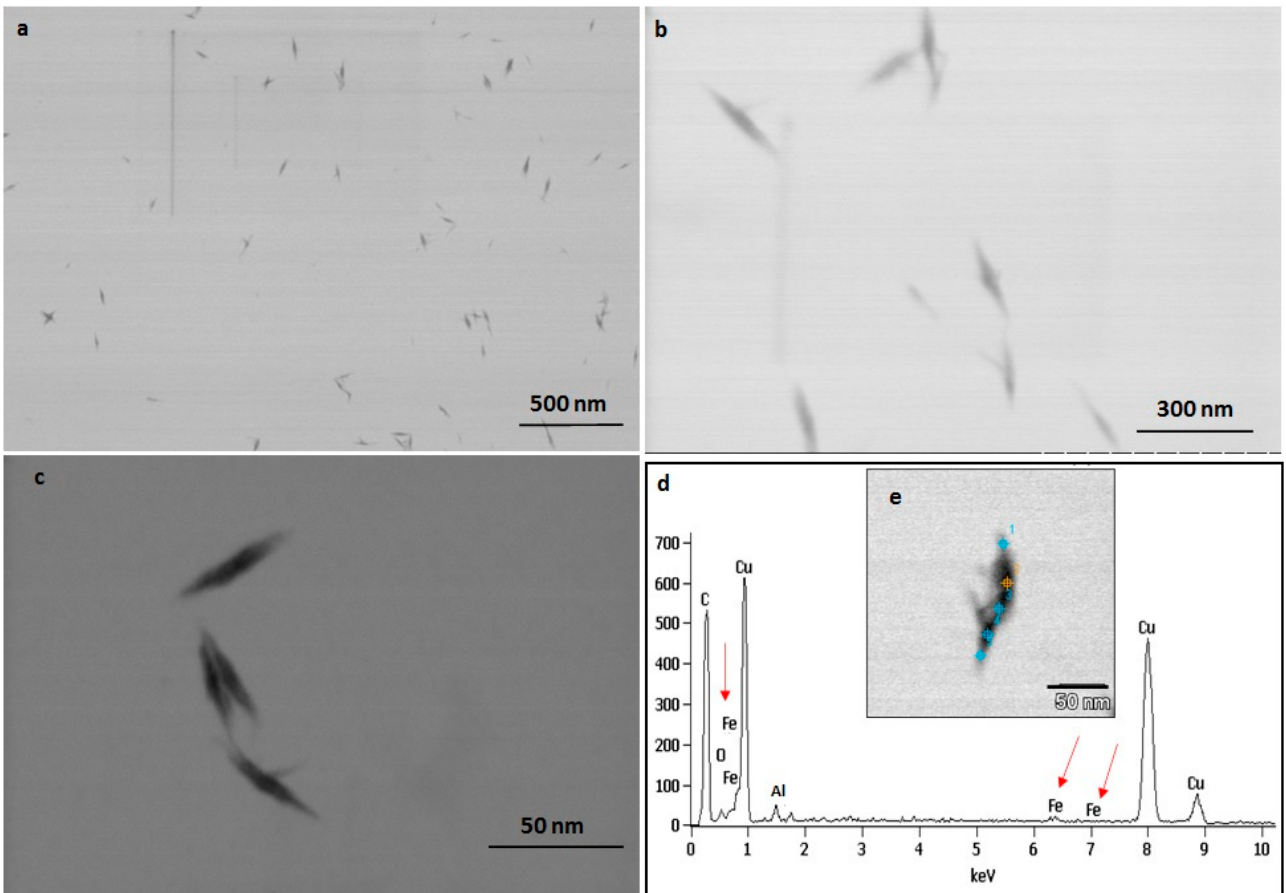
Figure 8. TEM images of extracellular IONPs captured in various magnification ( a – c ). EDAX study of single particle confirming presence of iron, oxygen ( d ). TEM image of single extracellular IONP ( e